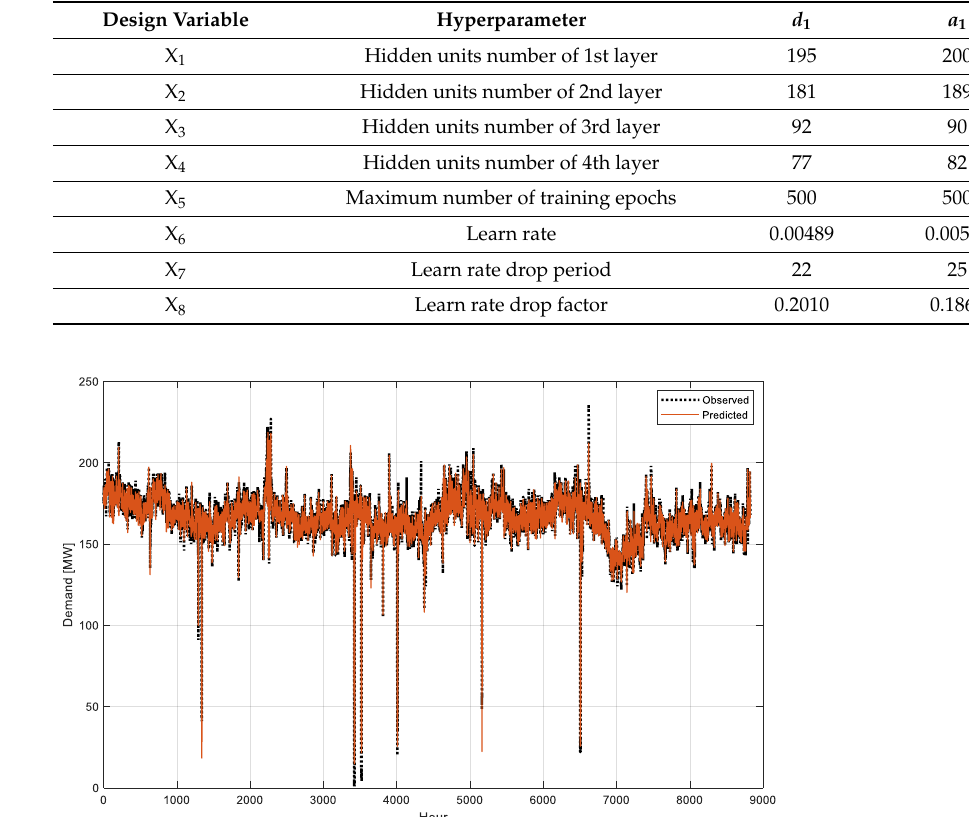
Table 3. Test results.